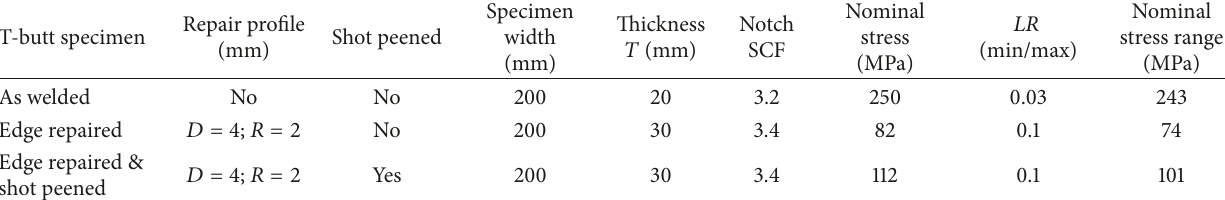
Table 1: Data for experimentally tested T-butt